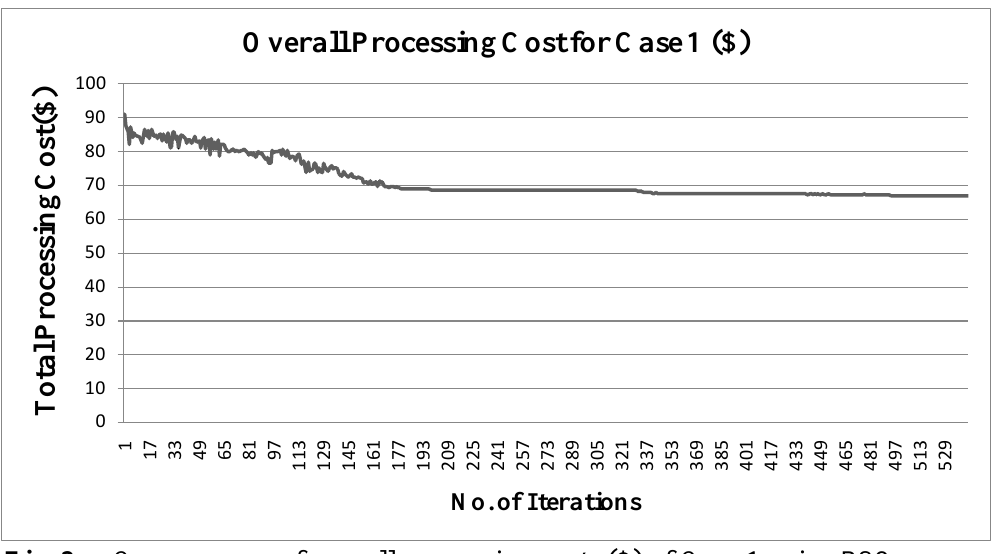
Table 4 corresponds to the optimal sequence of operations and associated cutting speeds of Case 1 that are obtained using PSO. This sequence results into overall processing cost of $66.78 including $45.2 machining and tool costs, $10.48 non-productive travelling cost, and $11.1 tool switch cost.